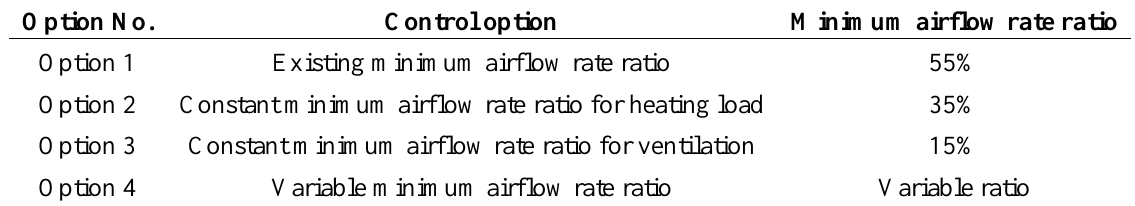
Table 1. Parameters for the control options.